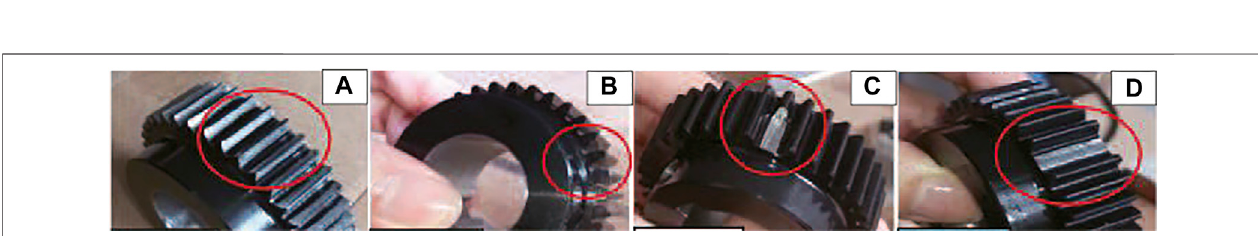
FIGURE 6 | Types of gear faults (Wang et al., 2018). (A) Surface wear of gear teeth (B) Crack gear teeth (C) Chipped gear teeth (D) Missing gear teeth.